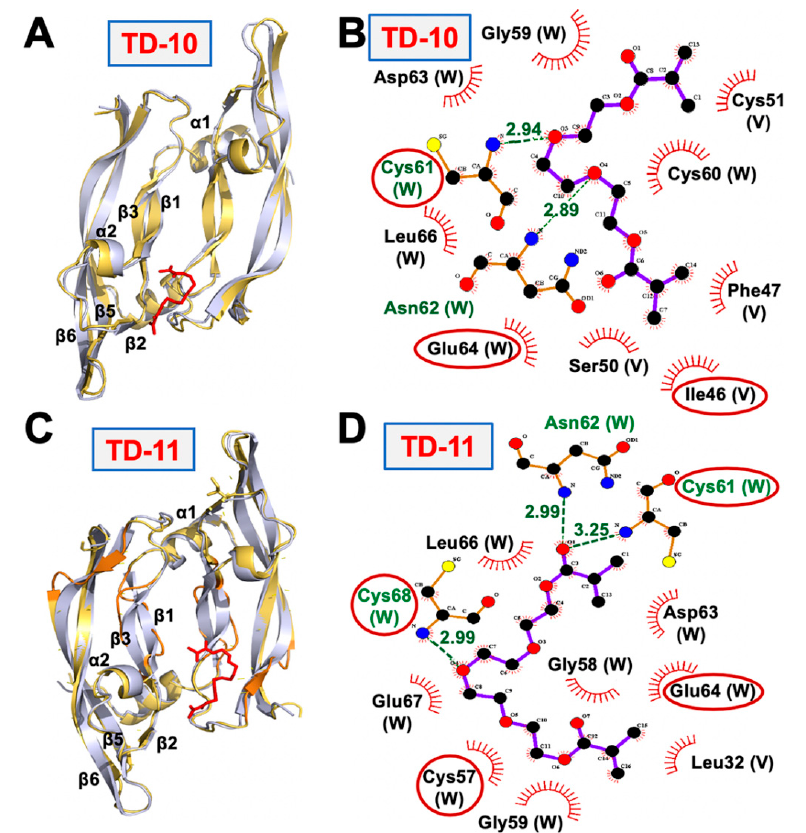
Figure 2. Superimposition of the structure of VEGFA protein dimer (grey) with VEGFA-TD-10 (yellow-red) complex ( A ) and VEGFA-TD-11 (yellow-red) Complex ( C ) interactions formed by TD-10 ( B ) and TD-11 ( D ) with VEGFA protein receptor-interacting interface. Interactions formed with key interacting residues are highlighted in red circles.